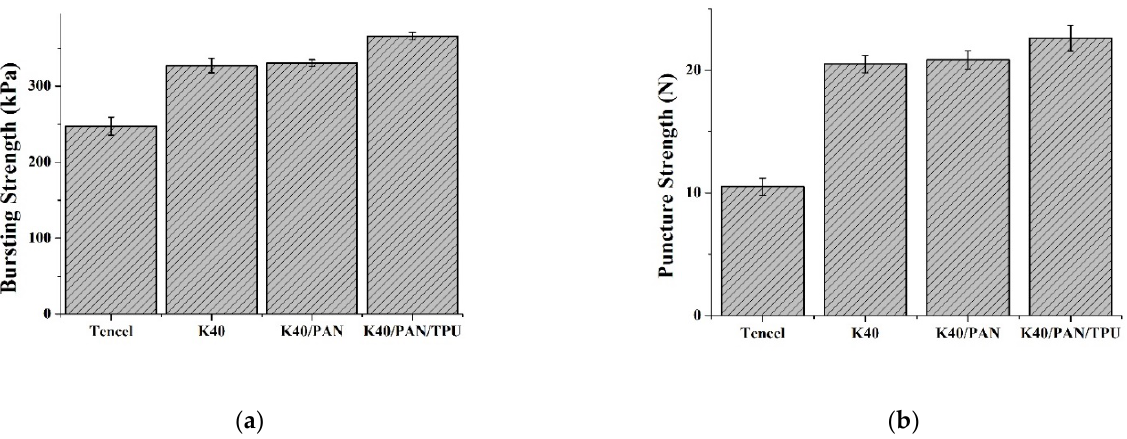
Figure 4. ( a ) Bursting strength and ( b ) static puncture resistance of Tencel, K40, and K40/PAN/TPU lay-up compound matrices.